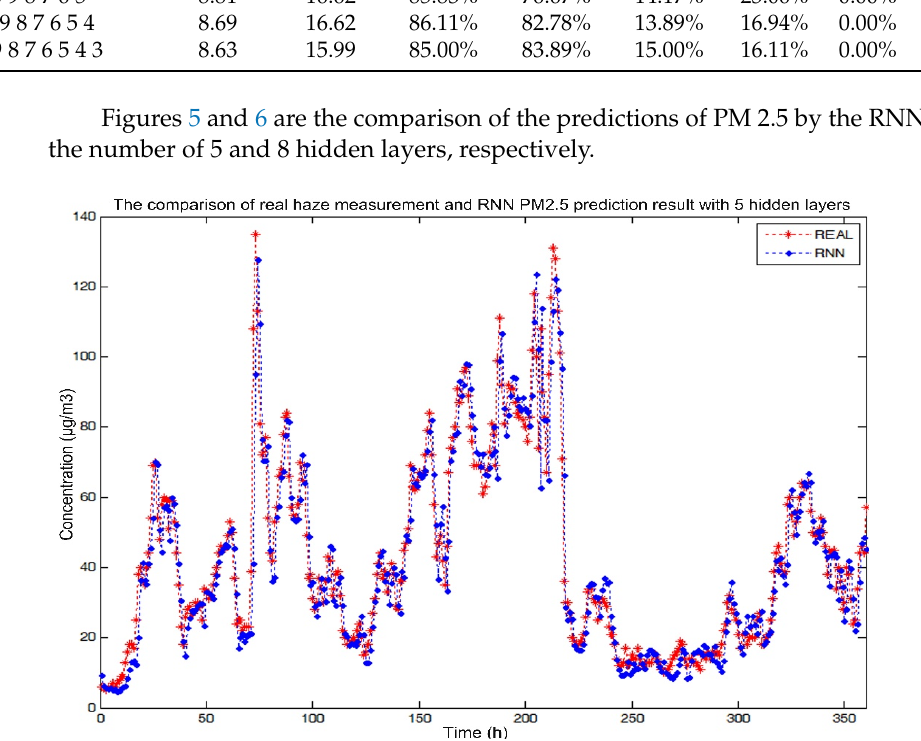
Figure 5. PM2.5 prediction results of 5 hidden layers of RNN network.